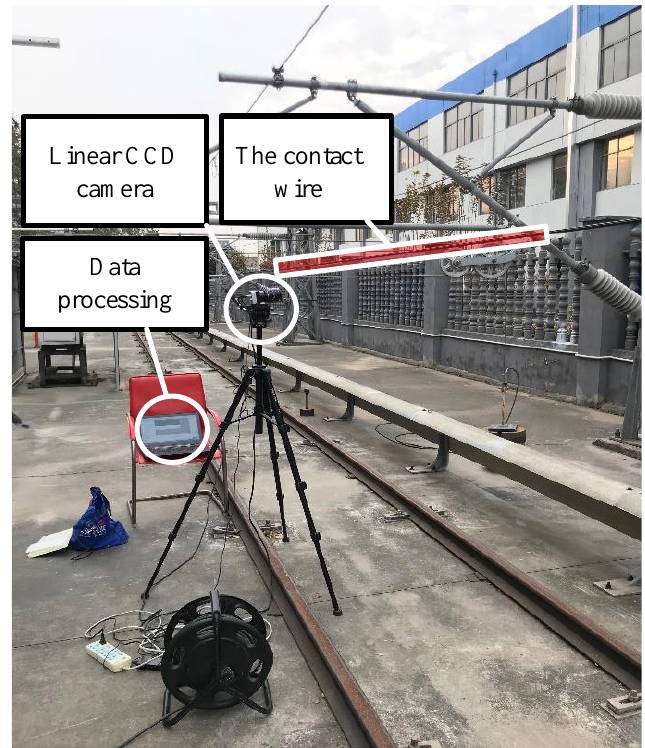
Figure 10. Setup for the field experiment of catenary vibration measurement.